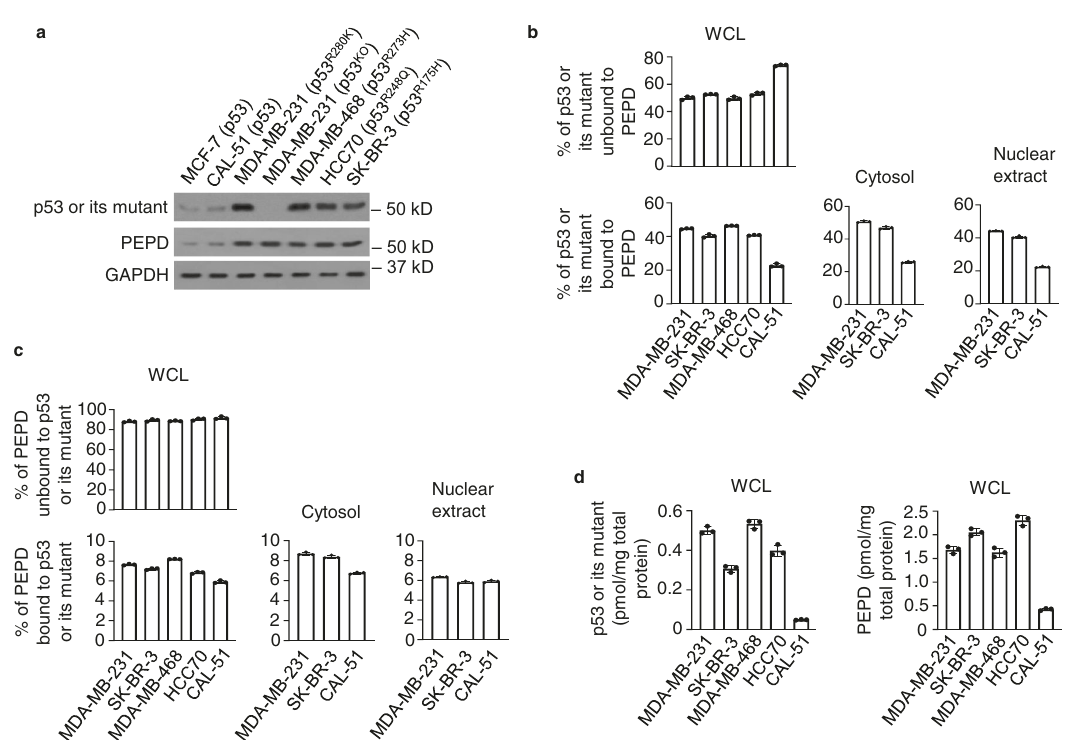
Fig. 2 PEPD binds to p53 mutants in cells. a WB analysis of p53, p53 mutants and PEPD in WCL of untreated cells. Glyceraldehyde 3-phosphate dehydrogenase (GAPDH) is a loading control. b , c PEPD, p53 or p53 mutant in a sample (WCL, cytosol or nuclear extract prepared from untreated cells) was completely pulled down by IP. An isotype-matched IgG was used as a control. Percentages of p53 or p53 mutant unbound to PEPD or vice versa were determined by measuring them in the supernatants using ELISA. The precipitates and an input were analyzed by WB for p53, p53 mutant and PEPD (Supplementary Figs. 2 and 3), and the percentages of p53 or p53 mutant bound to PEPD or vice versa were determined by comparing their band intensities with that of the inputs using ImageJ. d Levels of p53, p53 mutant and PEPD in WCL of untreated cells, measured by ELISA. The bar-dot plots in b – d show individual values and mean ± SD ( n = 3). p53 was included in each experiment for